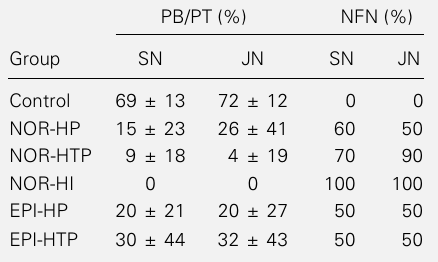
Table 3 - Representative single nephron glomeru- lar filtration rate in superficial (SN) and juxtamedul- lary (JN) nephrons obtained by the Hanssen tech- nique. Percent length of proximal tubules (PT) filled with Prussian blue (PB), and percent of non-filtering nephrons (NFN) in the control group and in the subgroups of rats treated with norepinephrine (NOR) and epinephrine (EPI), showing a homoge- neously (HP) and heterogeneously (HTP) perfused and homogeneously ischemic (HI) pattern. Data are reported as means – SD. PB/PT